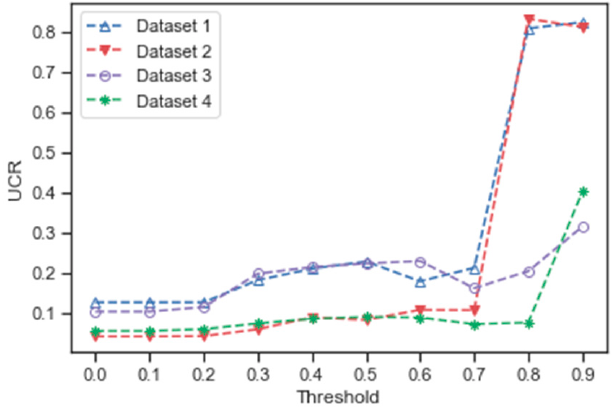
Figure 10. UCR curve with respect to different thresholds of the test datasets.